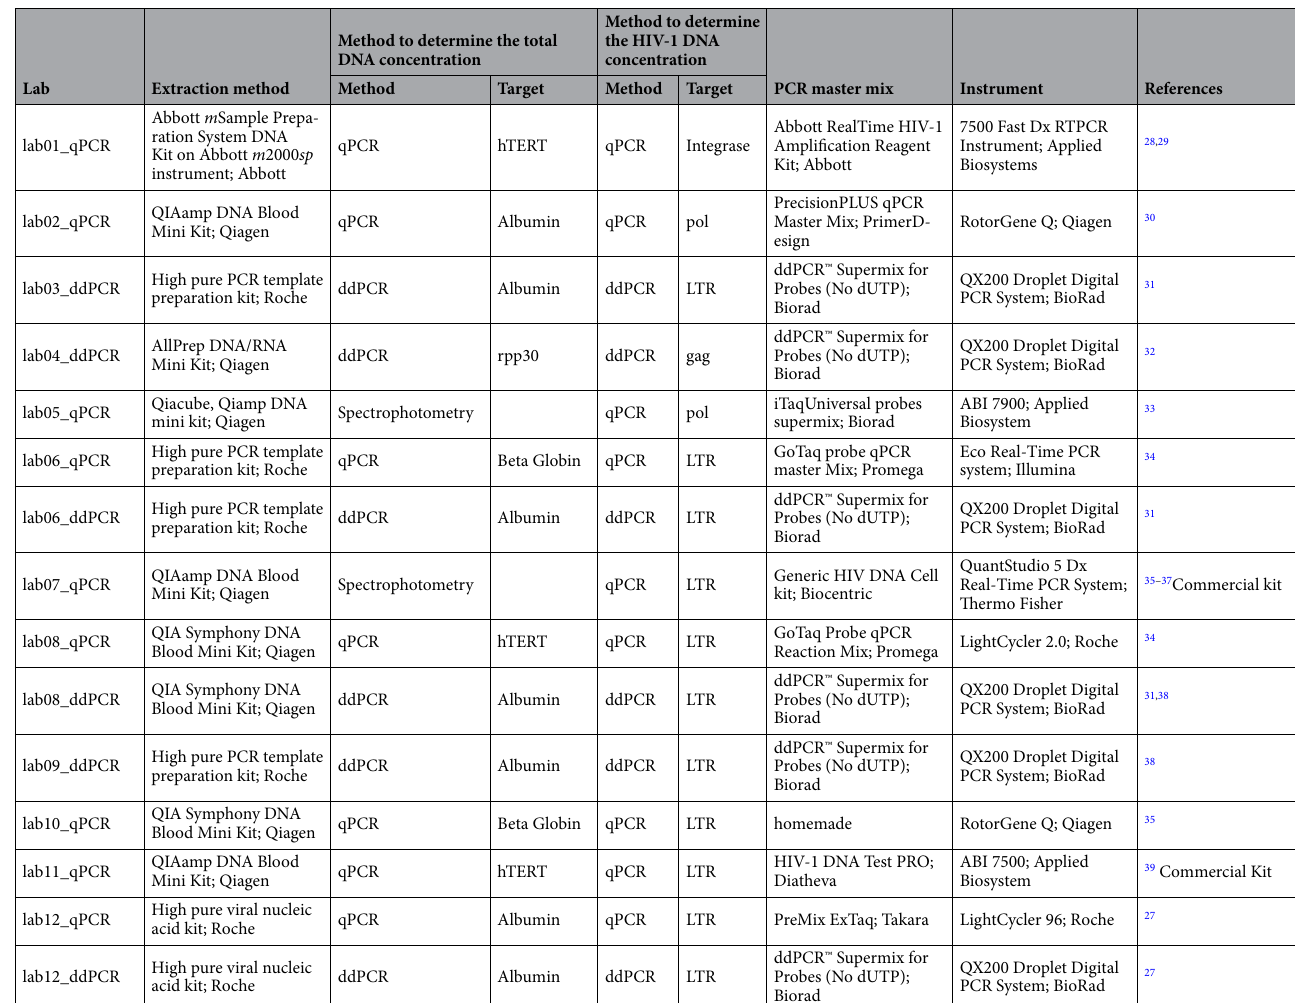
Table 2. Main features of the different methods used at each lab participating to the external quality assurance total HIV-1 DNA quantification program. hTERT human Telomerase Reverse